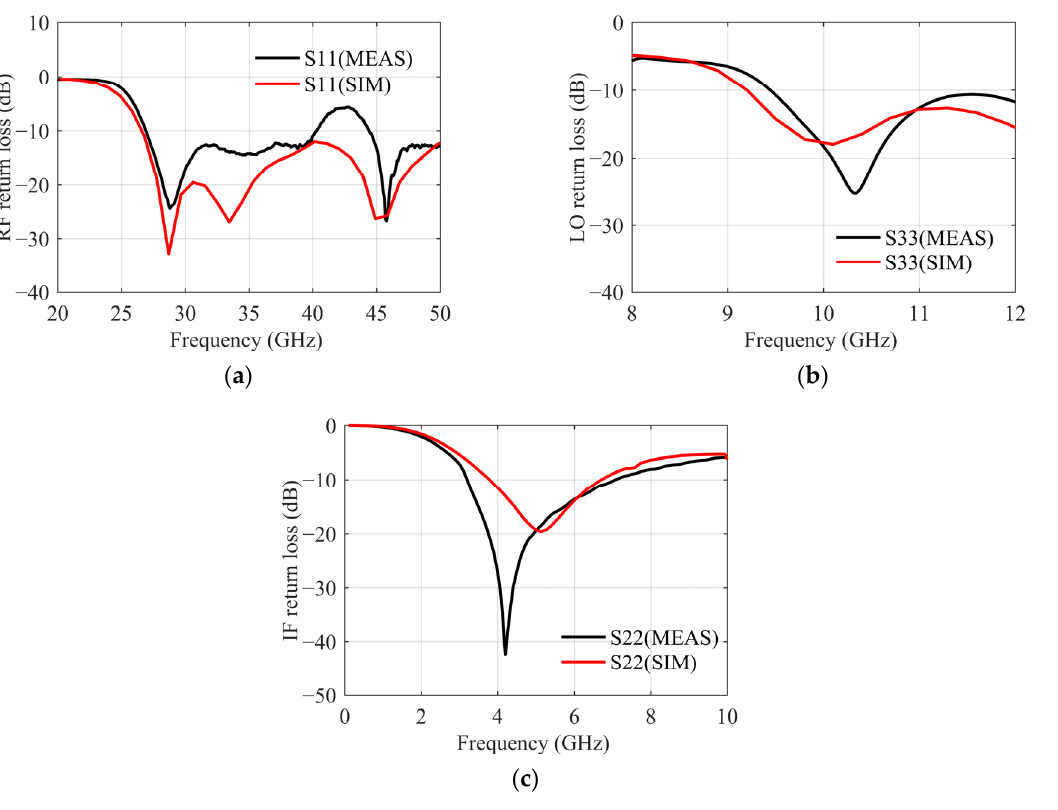
Figure 21. Return loss measurement results of each port. ( a ) RF return loss. ( b ) LO return loss. ( c ) IF return loss.